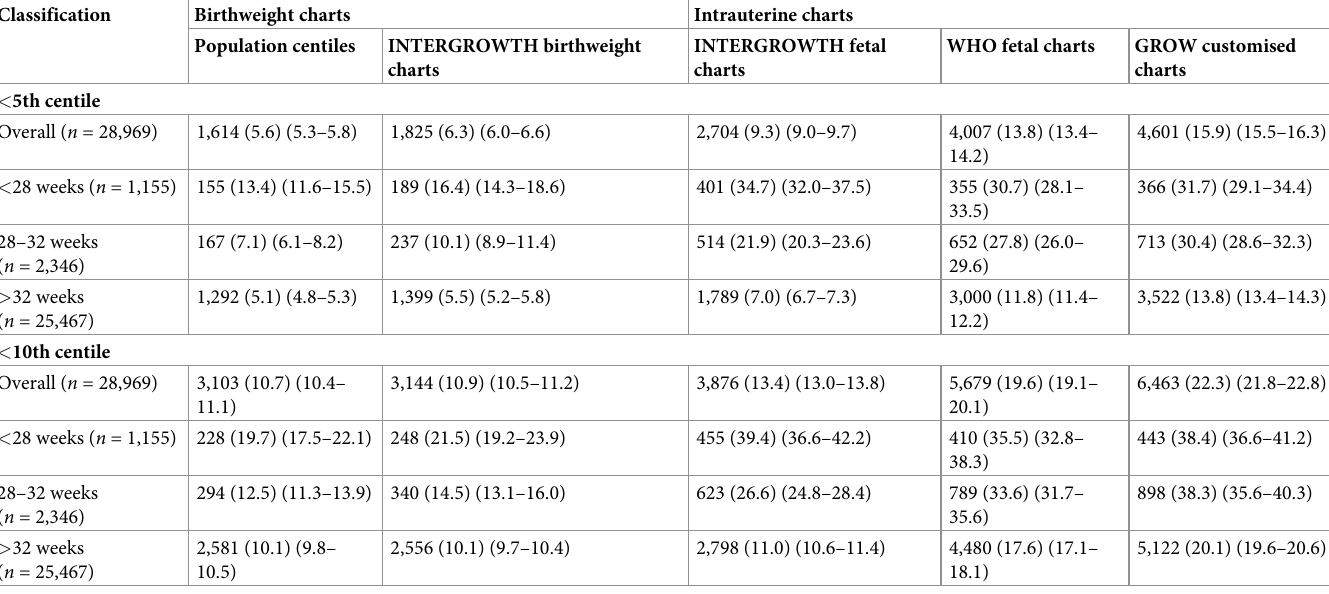
Table 1. Proportion of infants classified as < 5th and < 10th centile by different growth charts.